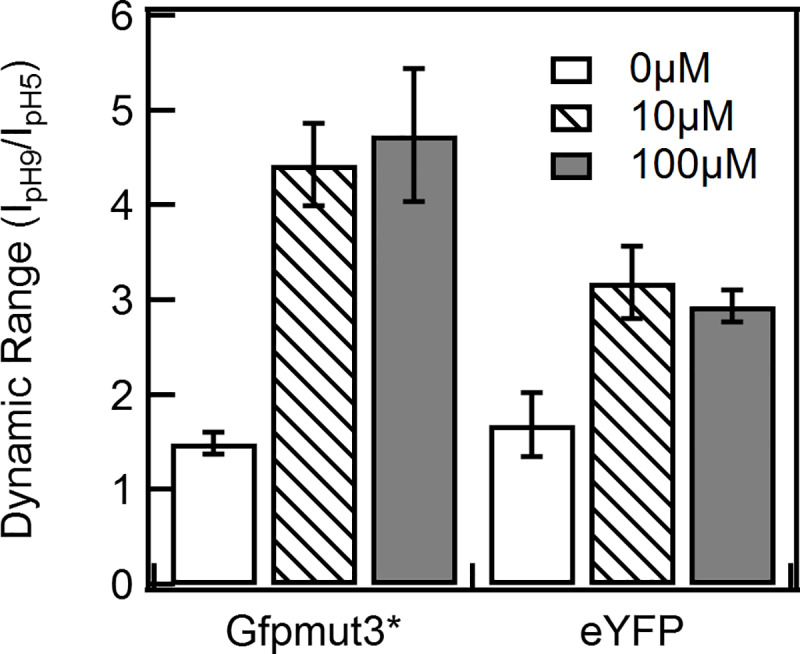
Dynamic range in pH measurements.Dynamic range–the ratio of the emission intensities at pH 9 (IpH9) and at pH 5 (IpH5)–are indicated for the intensity-based fluorophores. Induction levels are indicated in the figure legend; the difference in the means at 10 and 100 μM induction levels was not significant for either probes. Error bars were determined by error propagation.